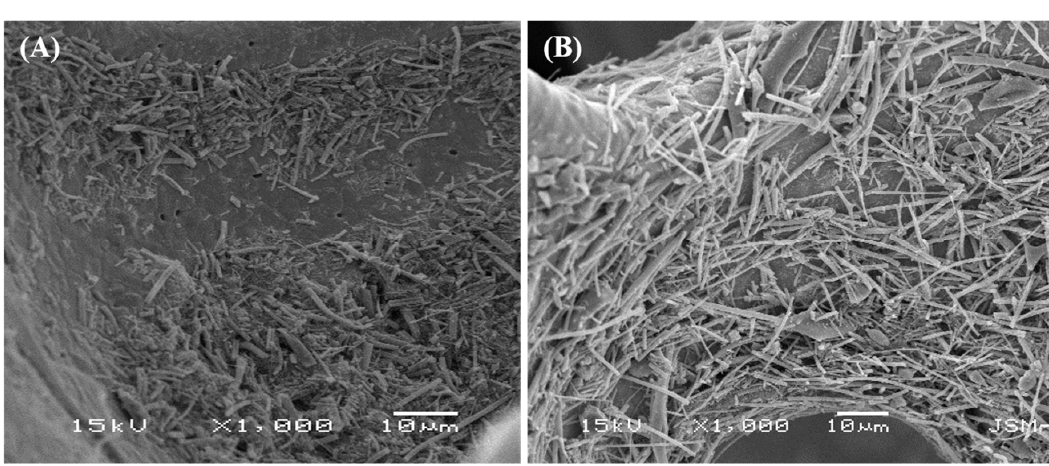
Figure 2. Scanning electron microscopy (SEM) image of the as-prepared slurry of titanium dioxide nanofibers (TiO 2 NFs) ( A ) and TiO 2 -carbon NFs ( B ) with carbon black and polyvinylidene fluoride (PVDF) in N -methyl-2-pyrrolidone (NMP).